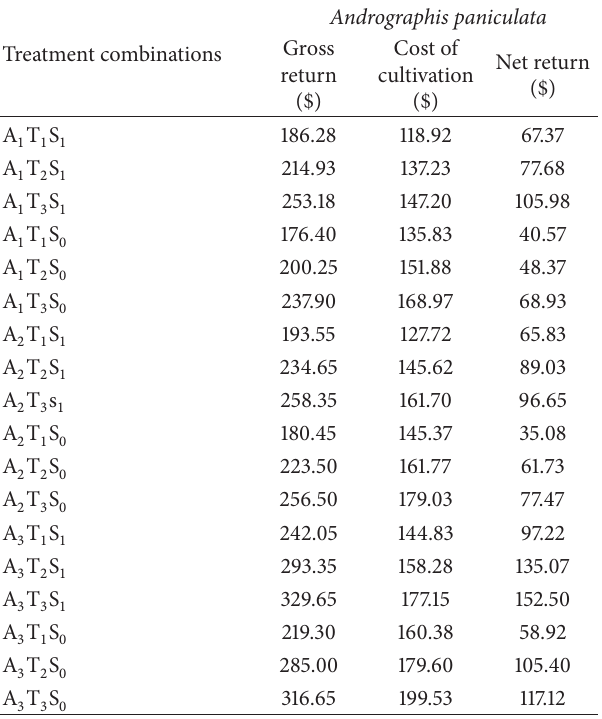
Table 6: Bioeconomic appraisal of Andrographis paniculata . Andrographis paniculata Gross Cost Treatment combinations